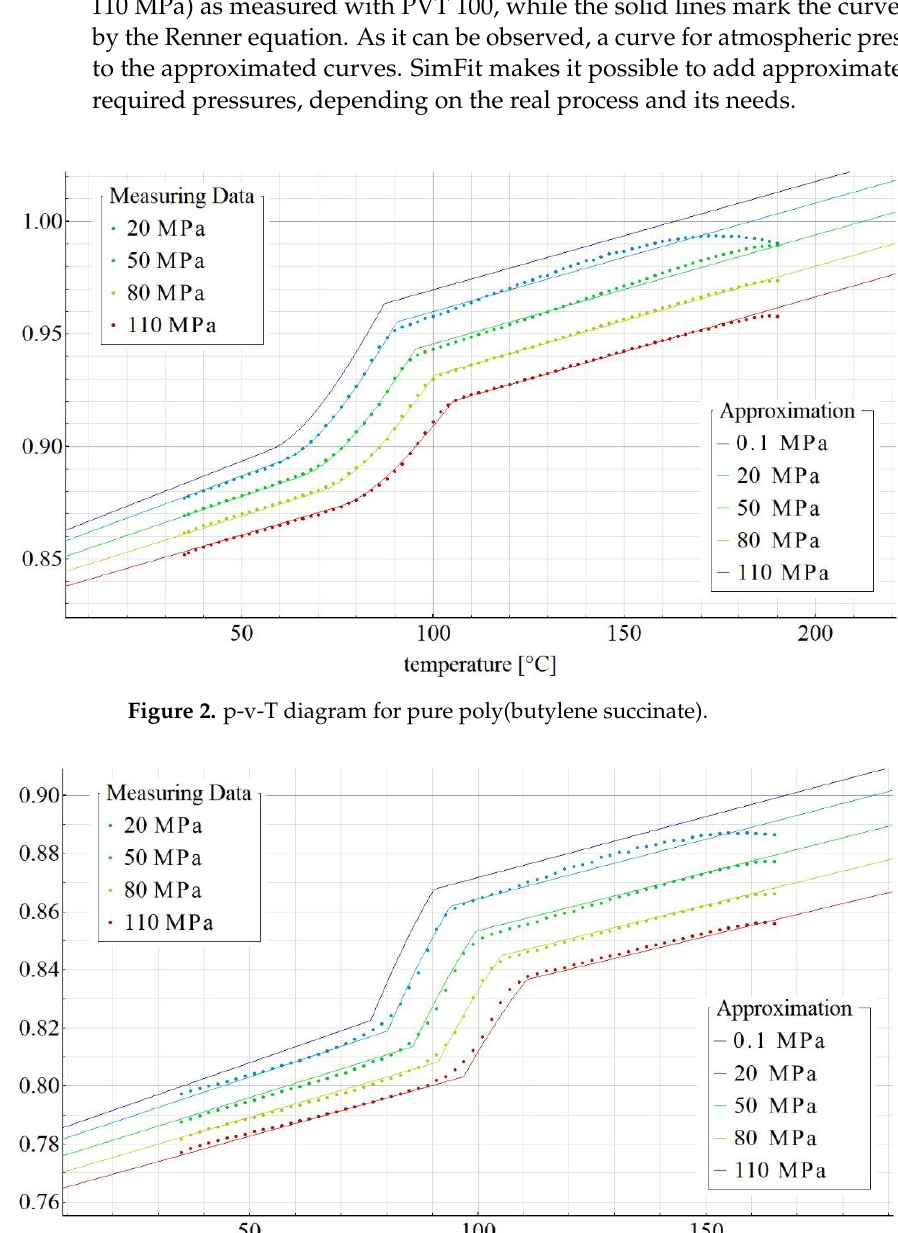
Table 2. Phase change temperatures for pure PSB and composite with variable filler content.